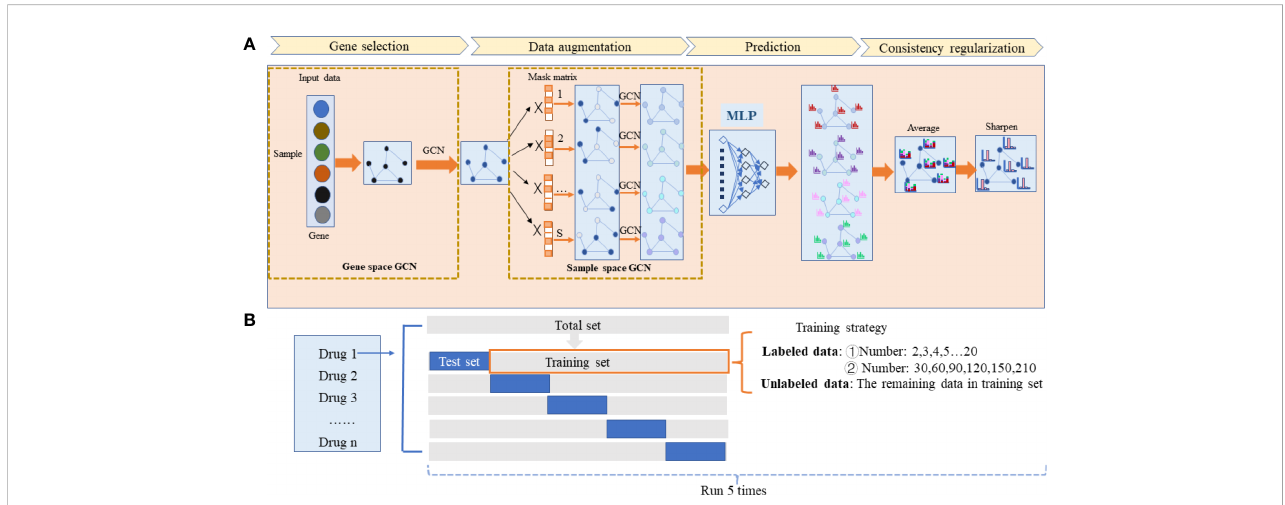
FIGURE 1 The work fl ow of the HiRAND framework and the analysis strategy. (A) HiRAND consisted of four main parts, including gene selection, data augmentation, prediction, and consistency regularization. Firstly, the feature embedding of gene expression pro fi les was obtained through GCN. Secondly, the multiple graph augmentations were generated by random propagation. Thirdly, the label prediction distribution was obtained through MLP. Fourthly, the fi nal label results were used through consistency regularization. (B) For each drug response prediction task, we conducted 5-fold cross-validation to benchmark the predictive power of HiRAND. For the labeled data sample size setting, we considered two aspects: ① very few labeled sample size (2,3,4,5,6 … 20) and ② relatively large labeled sample size (30,60,90,120,150,210). The remaining data in the training set were treated as unlabeled data. This process was repeated fi ve times to show the robustness of